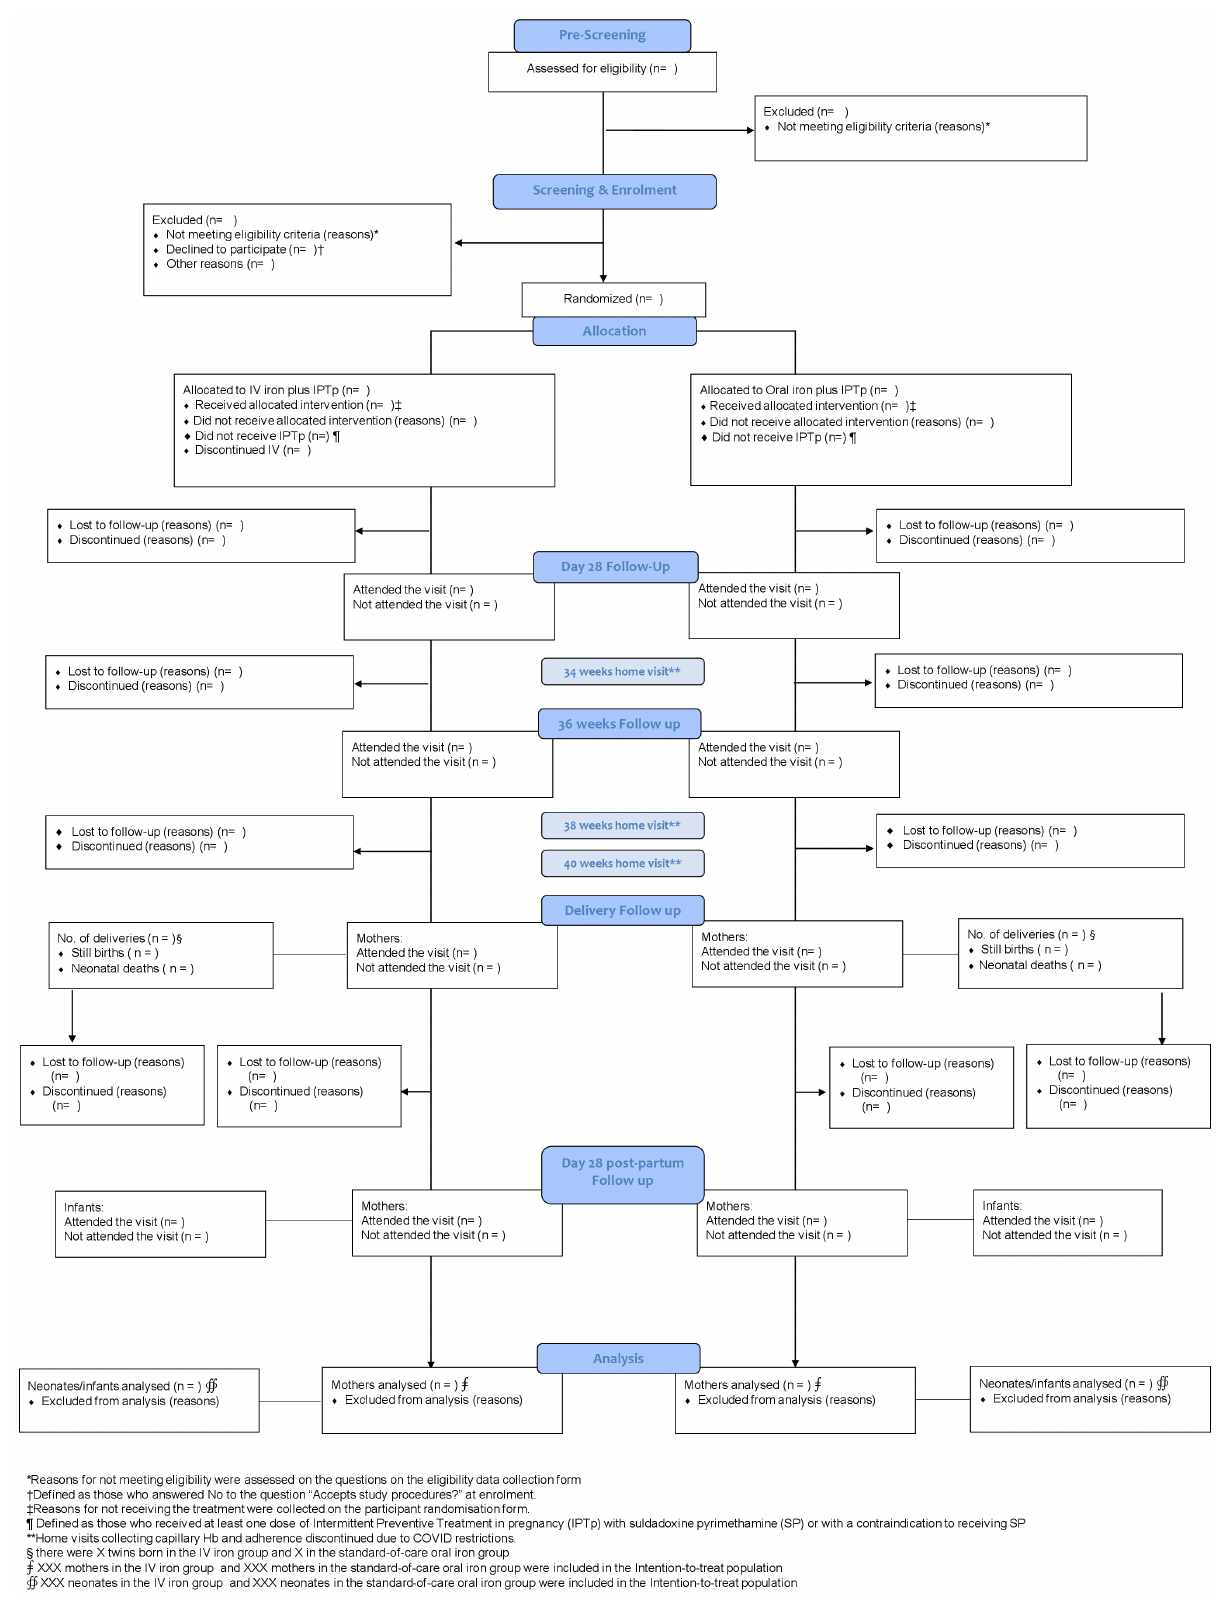
Figure 2. The CONSORT flow